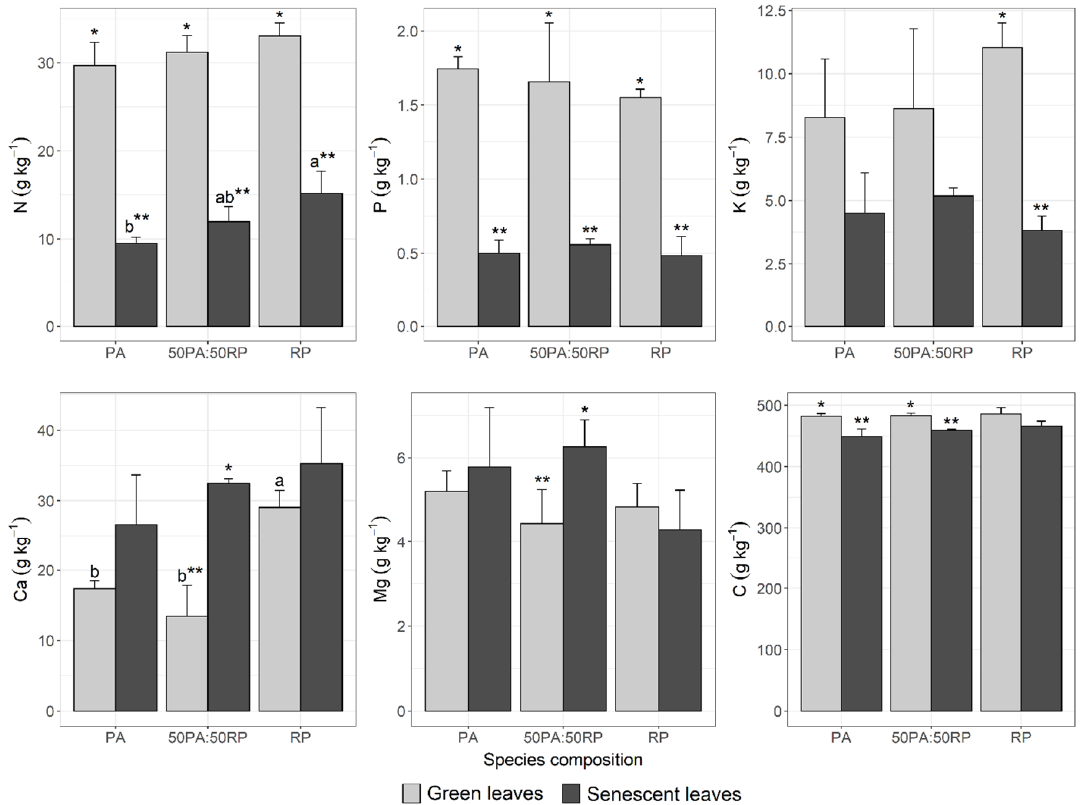
Figure 3. Weighted annual averages according to weight fraction and their standard deviation for macronutrients and C in green and senescent leaves of P. alba (PA) and R. pseudoacacia (RP) monocultures and 50PA:50RP mixture. The significance between plot types for green leaves, and also for senescent leaves, is shown by letters; and the significance between green and senescent leaves within the same plot (PA, 50PA:50RP and RP respectively) is shown with asterisks. Both letters and asterisks are only shown when significant differences were found.